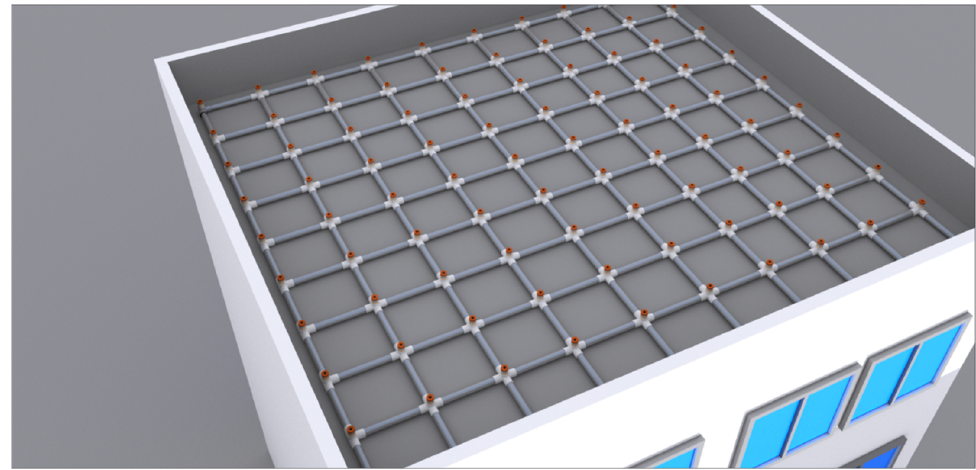
Figure 2. PVC pipeline network for water storage and self-irrigation.